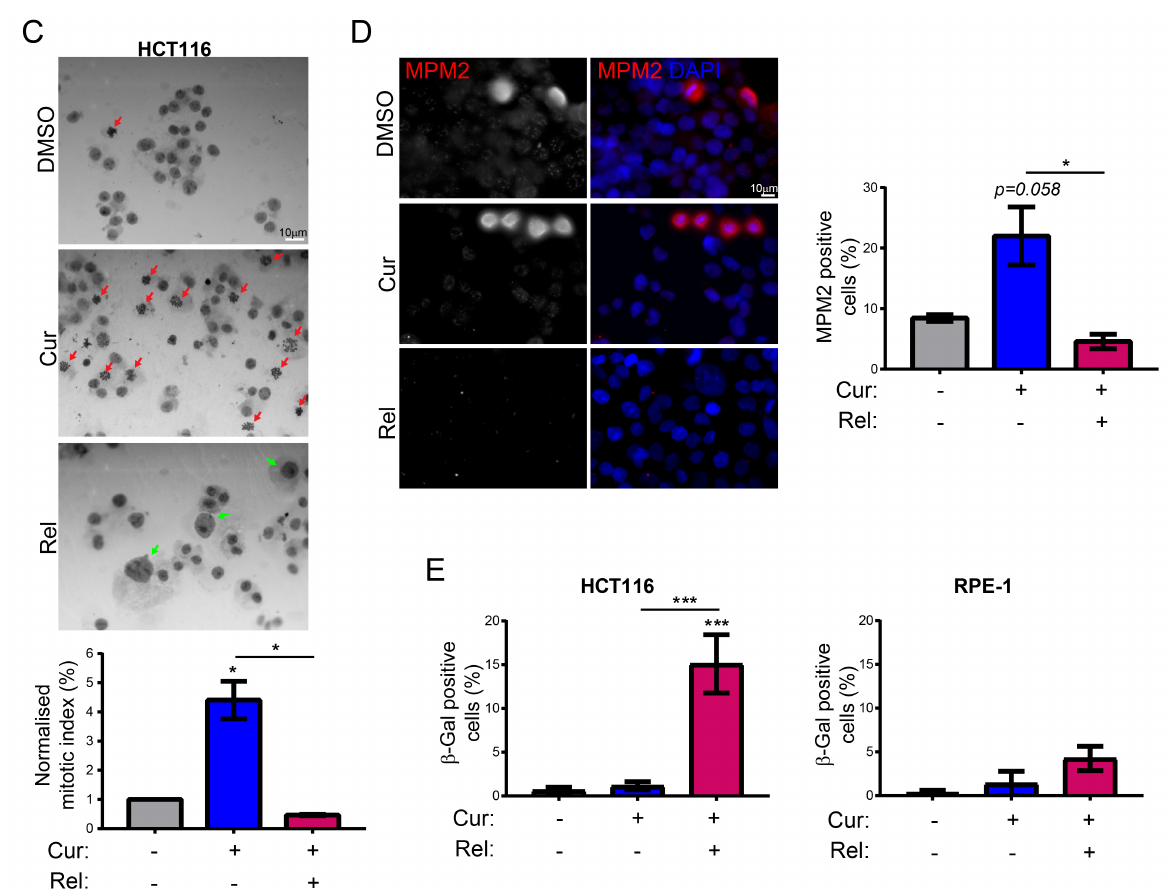
Figure 1. Curcumin treatment selectively induces cell senescence in cancer cells following exit from cell-cycle arrest in mitosis: ( A ) Schematics of the experiment workflow; ( B ) representative flow- cytometric profiles showing the distribution throughout the cell cycle of propidium iodide-labeled HCT116 and RPE-1 cells treated with DMSO (control), with Curcumin, for 24 h (Cur), and then released for 72 h (Rel). Graphs summarizing the results of three independent experiments. Un-paired t -test: *** p < 0.001, ** p < 0.01; ( C ) representative Giemsa-staining images of HCT116 cells with the indicated treatment. Scale bar = 10 µ m. Graph summarizing the results of three independent experiments. Red arrows point to mitotic cells. Green arrows point to abnormal big nuclei. Un- paired t -test: * p < 0.05; ( D ) representative immunofluorescence images showing MPM2-positive HCT116 cells in the indicated treatments. Scale bar = 10 µ m. Graph summarizing the results of three independent experiments. Un-paired t -test: * p < 0.05. ( E ). Graphs showing the percentage of SA- β -Gal-positive cells in the indicated cell lines and treatments. n = 3 (HCT116), n = 4 (RPE-1). Un-paired t -test: *** p <